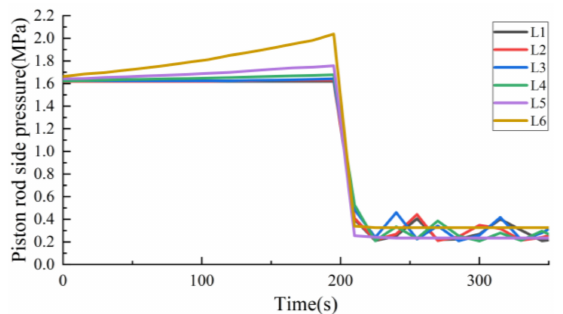
Figure 21. Piston rod side pressure of different leakage flow.